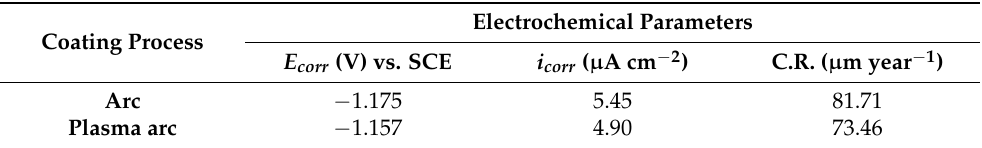
Table 5. Electrochemical parameters obtained after the fitting of potentiodynamic polarization plots in the Tafel